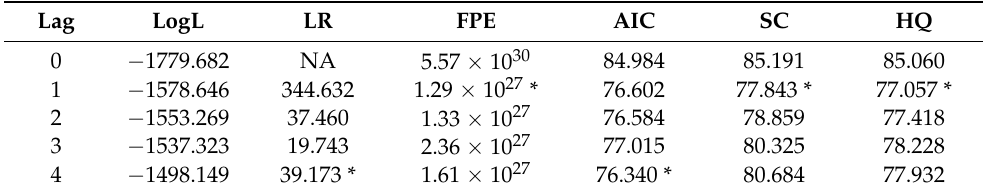
Table 4. Lag Length Selection Criterion.